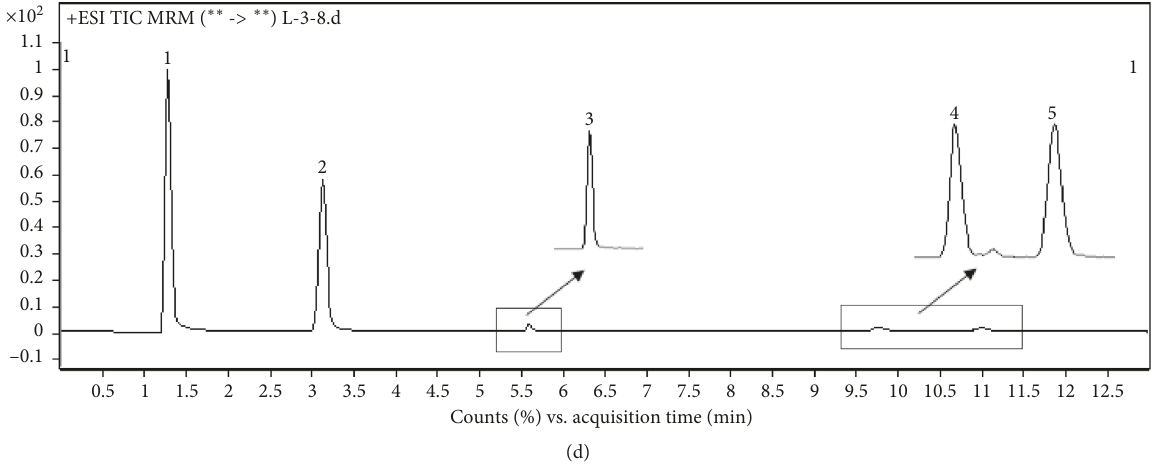
Figure 3: HPLC-MS/MS MRM chromatograms of (a) blank plasma, (b) spiked plasma with IS, (c) spiked blank plasma with PMZ, PMZSO, schisandrin, and IS samples, and (d) actual rat plasma samples collected at 1h after oral administration. 1: metronidazole; 2: PMZSO; 3: PMZ; 4: schisandrin; 5: